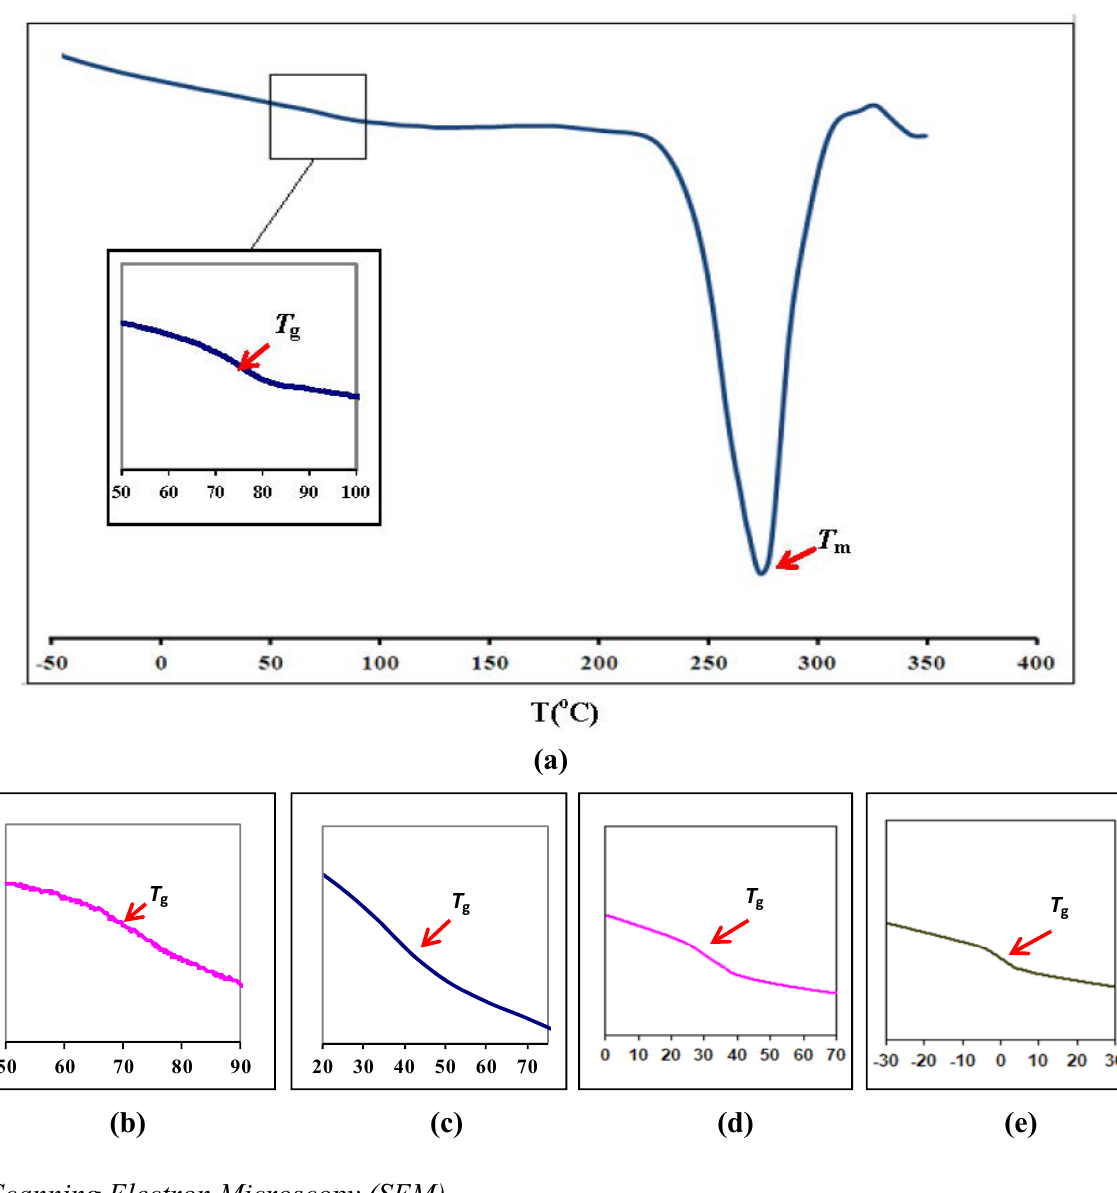
Figure 1. Differential Scanning Calorimetry curve for ( a ) PEMA; ( b ) PEMA-NH and PEMA-NH ( e ) 35 wt %